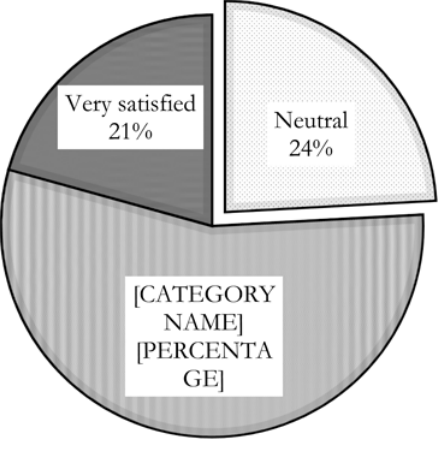
Figure 1 The frequency distribution of the respondents’ overall job